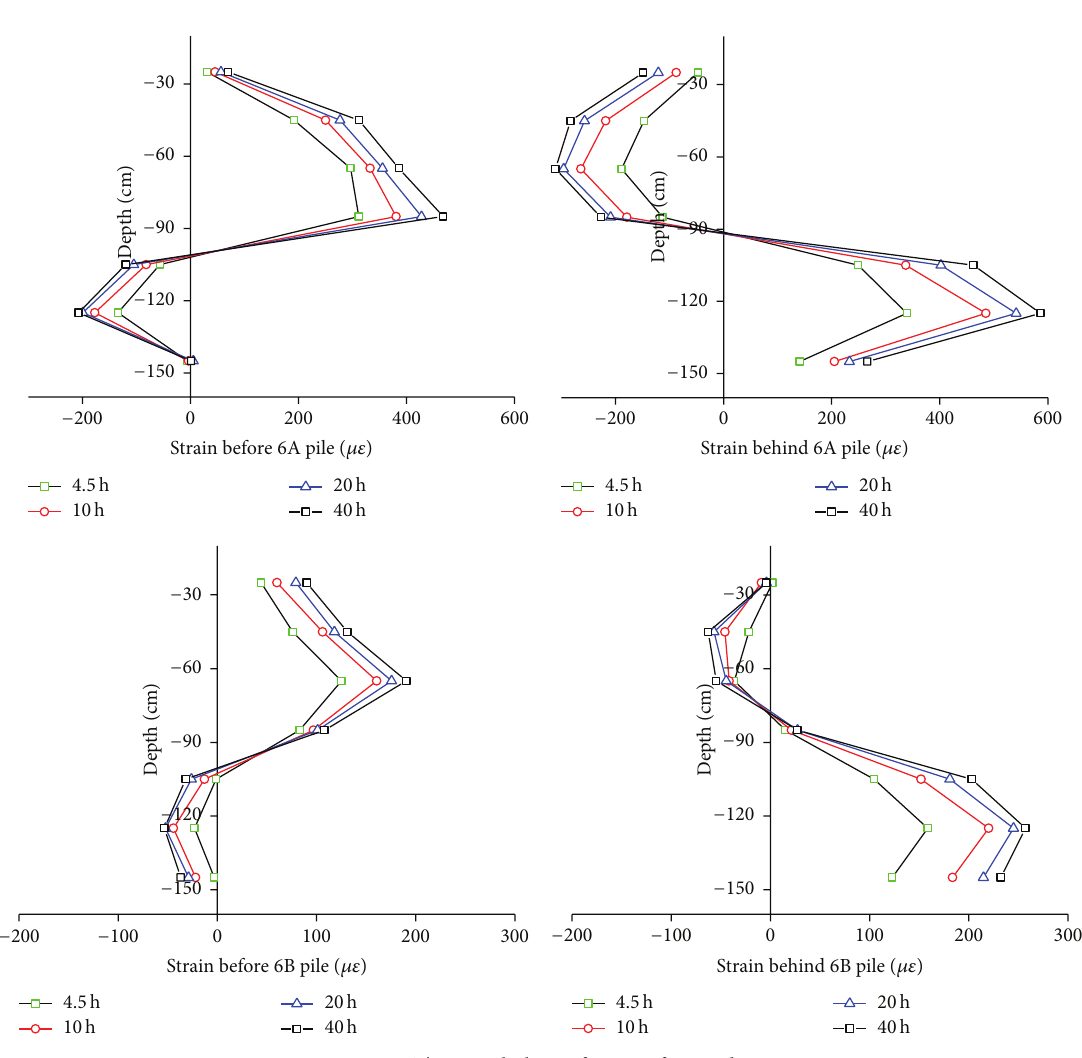
Figure 14: The morphology of strain of 6A and